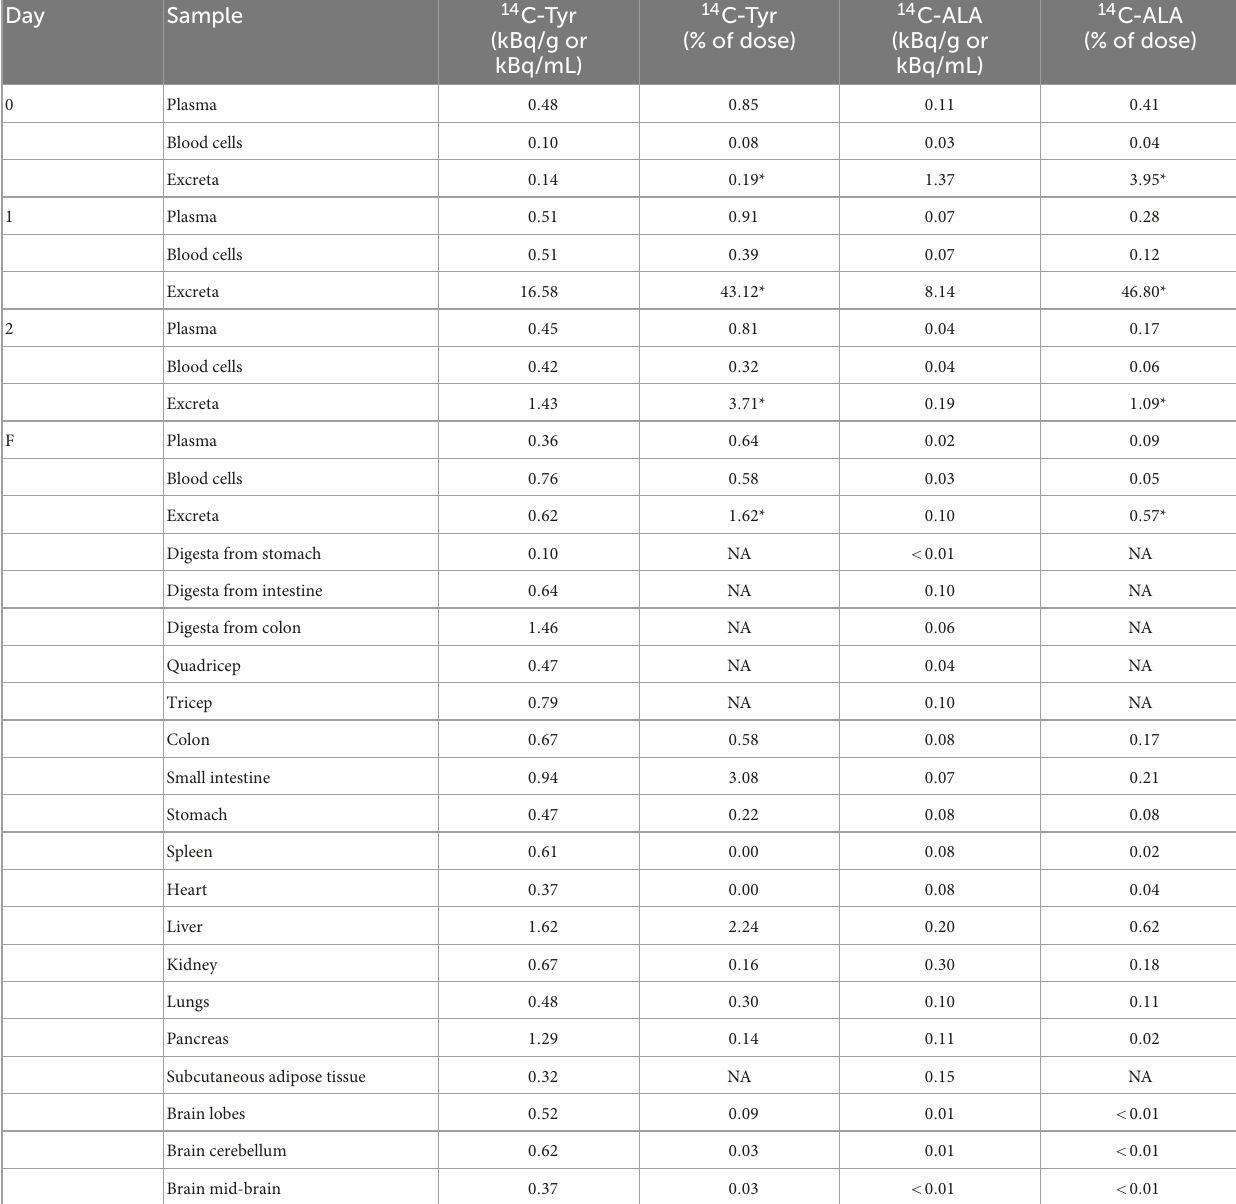
TABLE 2 Radioactivity measured in blood, excreta, and selected tissues and organs for 14 C-ALA ( n = 1) and 14 C-Tyr ( n = 1), as concentration and percentage of original dose (20 MBq). Day Sample 14